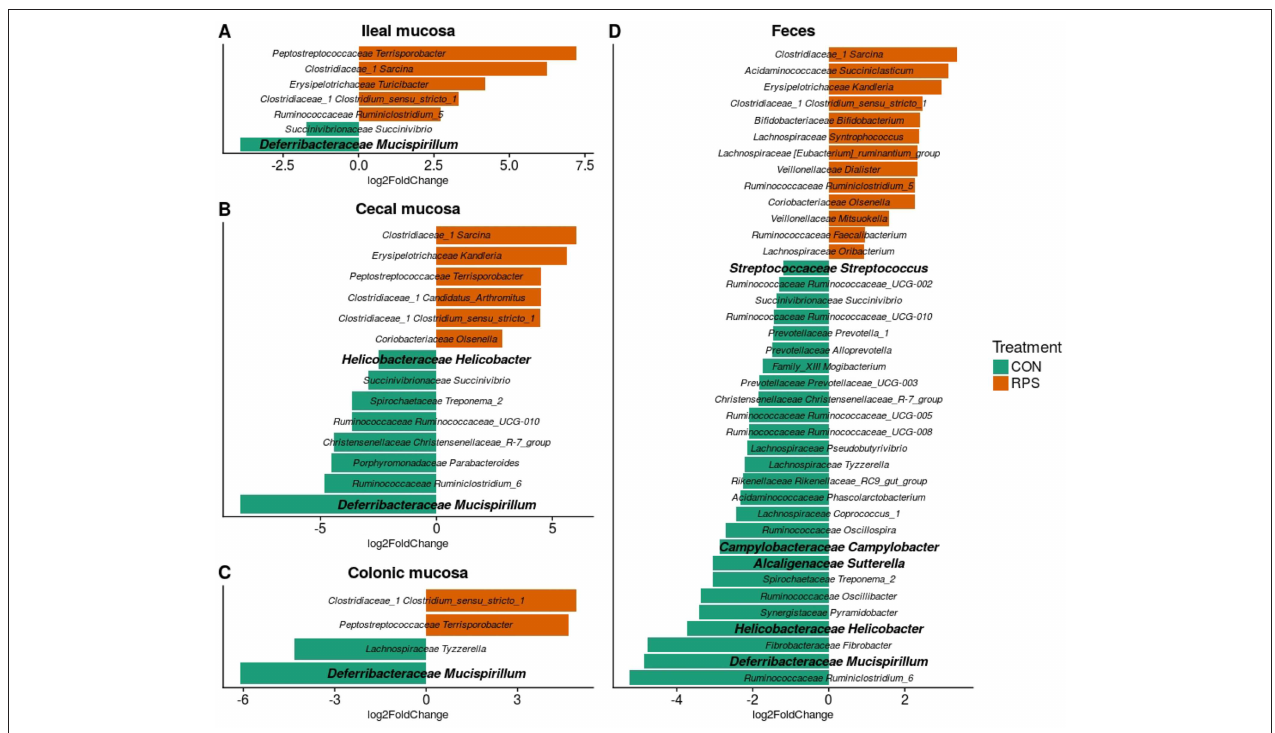
FIGURE 3 | Differentially abundant ( p < 0.05) genera based on 16S rRNA gene sequences from the ileal mucosa (A) , cecal mucosa (B) , colonic mucosa (C) , and feces (D) as determined by DeSeq2. OTUs clustered at 97% similarity were combined by taxonomic classification at the genus level. The results shown are log 2 fold change between the CON (control; green) and RPS (resistant potato starch; orange)-fed groups; note that the x-axis scale is different for each panel. Positive log-fold changes indicate that a genus is enriched in the RPS group, while negative log-fold changes indicate that a genus is enriched in the CON group. The SILVA classification for each genus is labeled on the figure using both the family and genus name. Genera shown in bold are those that harbor species with the capacity for respiration.